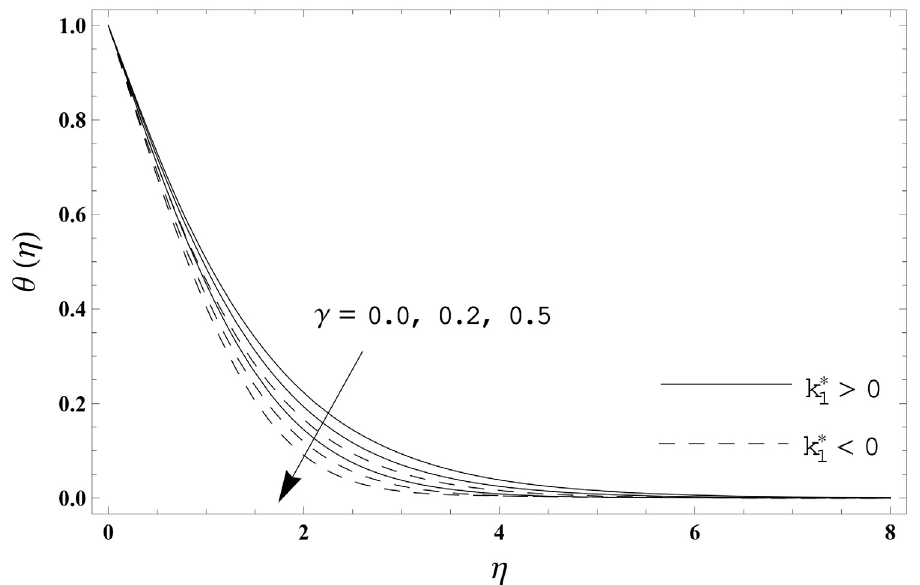
C f x > 0 Þ and second grade 1